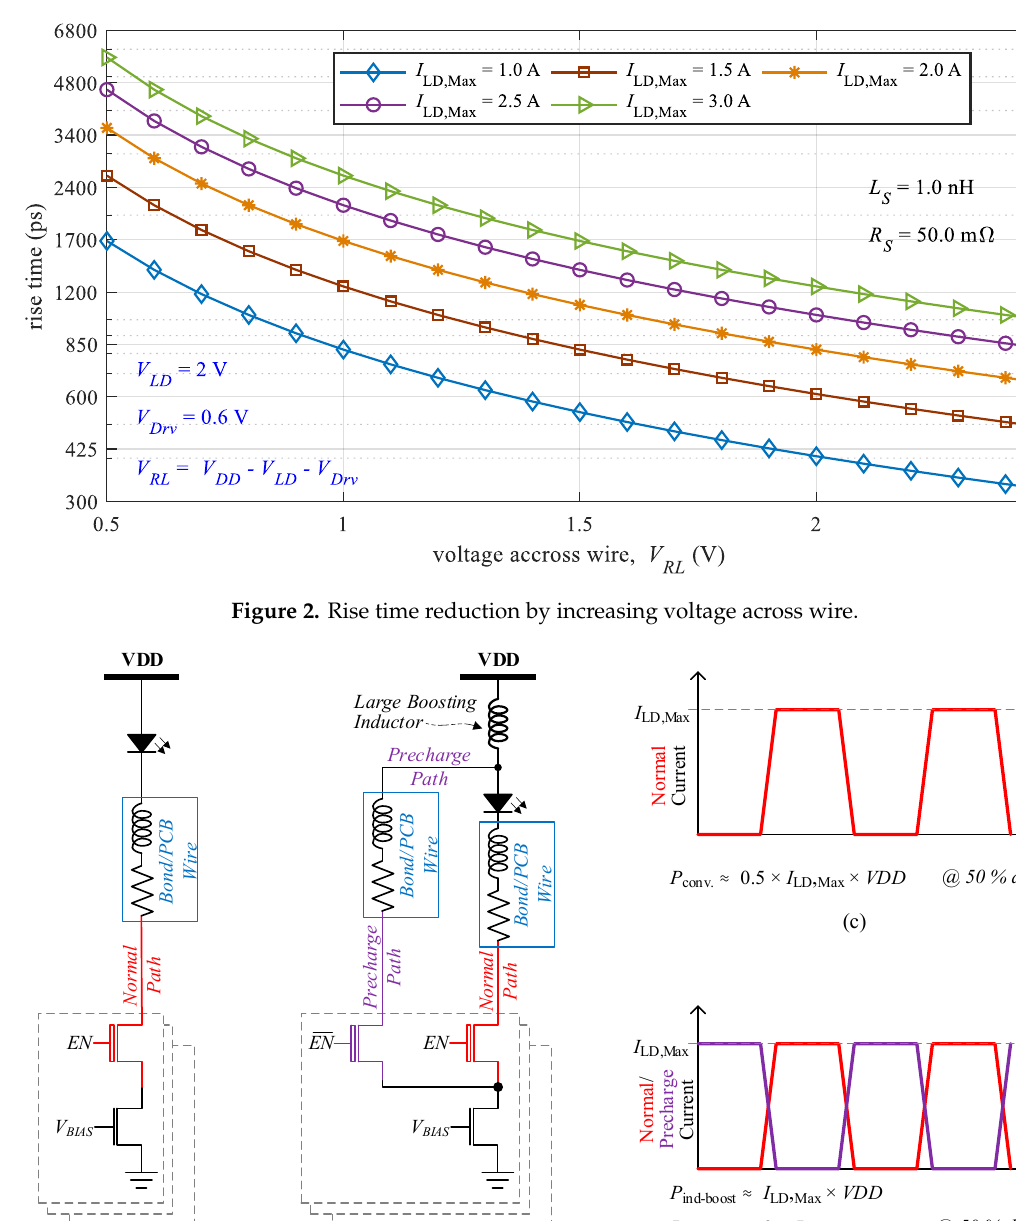
Figure 2. Rise time reduction by increasing voltage across wire.